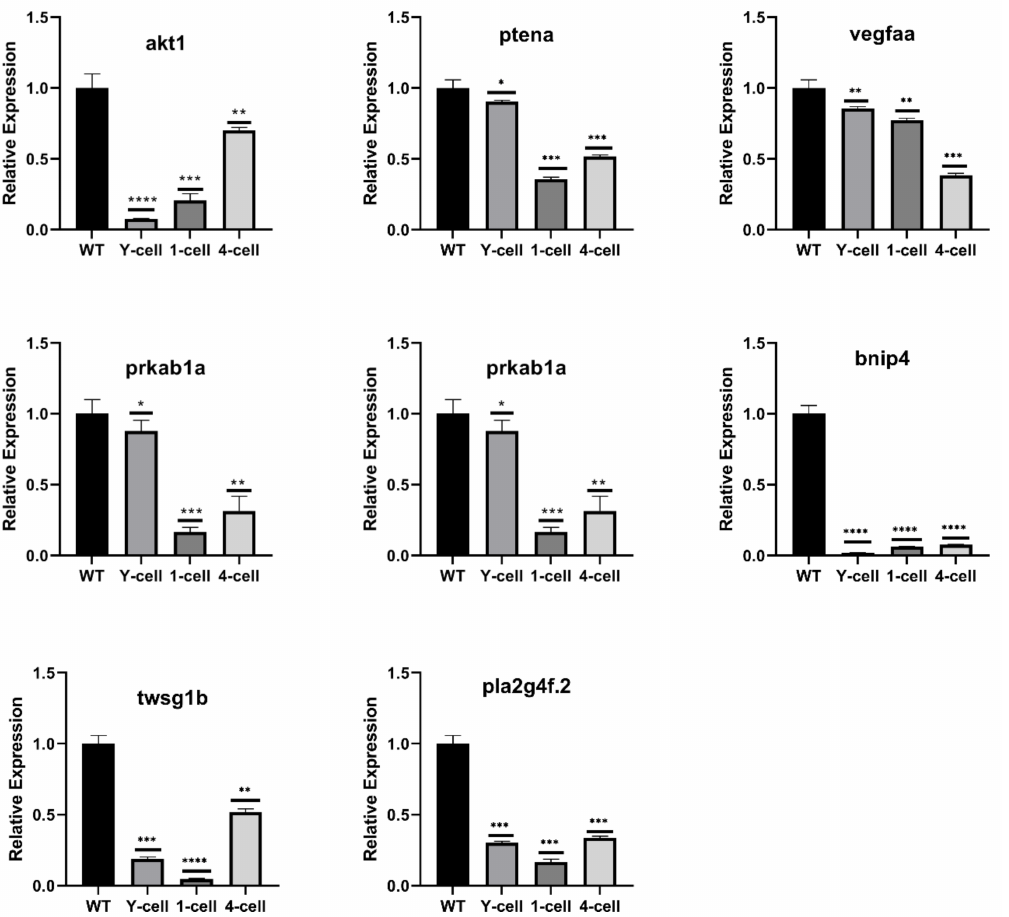
Figure 6. Validation of RNA-Seq data by qRT-PCR. Eight significantly down-regulated DEGs highlighted in GO enrichment and KEGG signaling pathway related to skeletal development. All the selected DEGs showed the same expression pattern in both RNA-Seq and qRT-PCR analysis. The results are represented as means ± SEM, * p < 0.05, ** p < 0.01, *** p < 0.002, **** p <